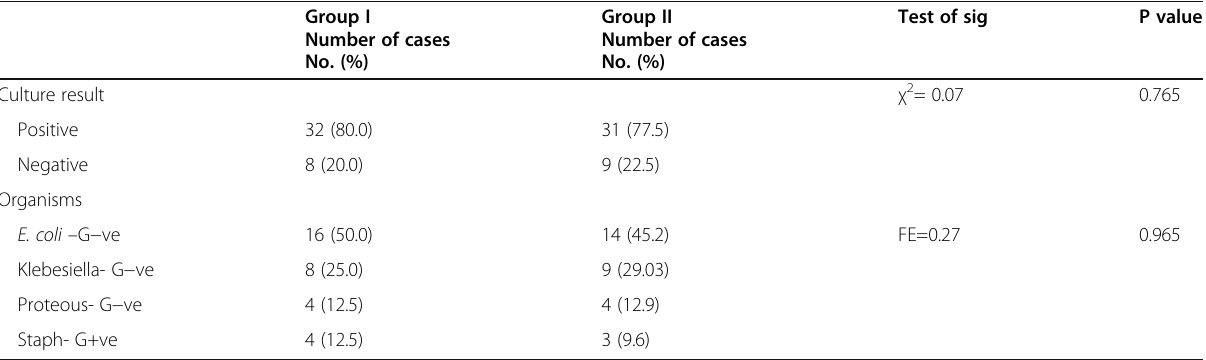
Table 2 The patients ’ ascitic fluid culture analysis